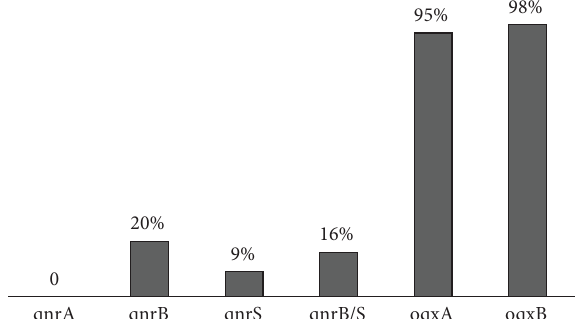
Figure 2: Te prevalence of qnr and efux pump genes is K. pneumoniae